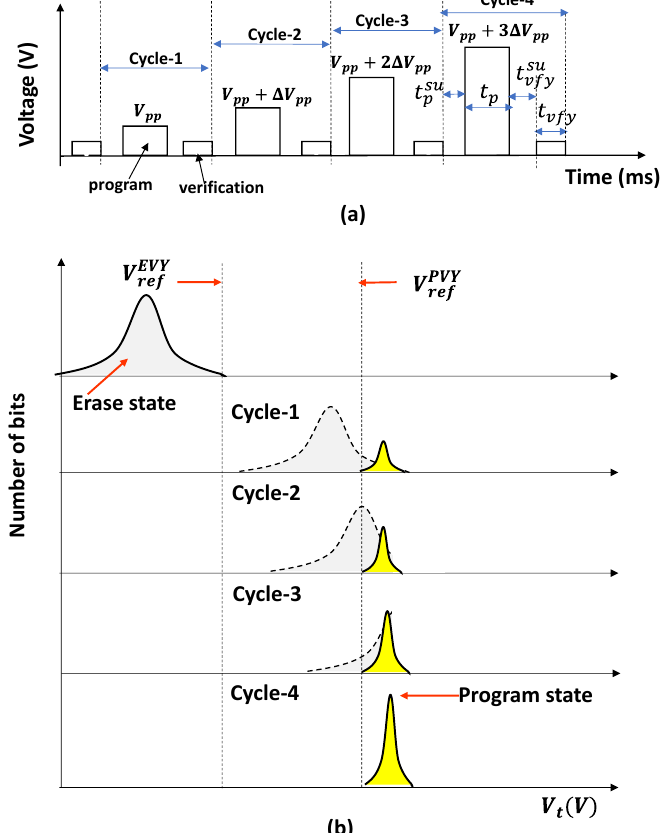
Figure 2. ISPP scheme: ( a ) an illustration of the ISPP scheme with 4 program cycles; ( b ) evolution of the V t state for the program state over consecutive program cycles; the distribution in yellow at the bottom represents the final program state.